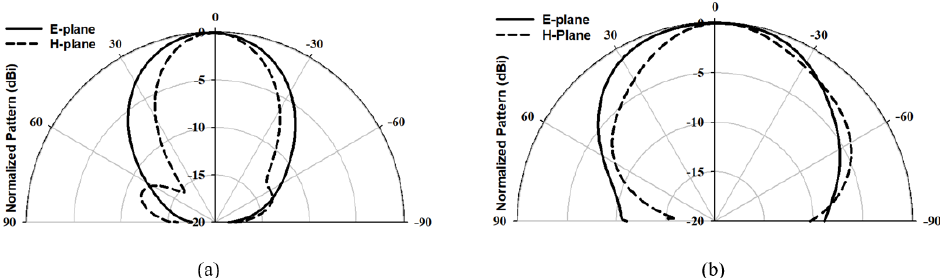
Figure 18. The E and H planes radiation pattern of the integrated DRA and perforated substrate configuration ( a ) 22.7 GHz ( b ) 27 GHz.